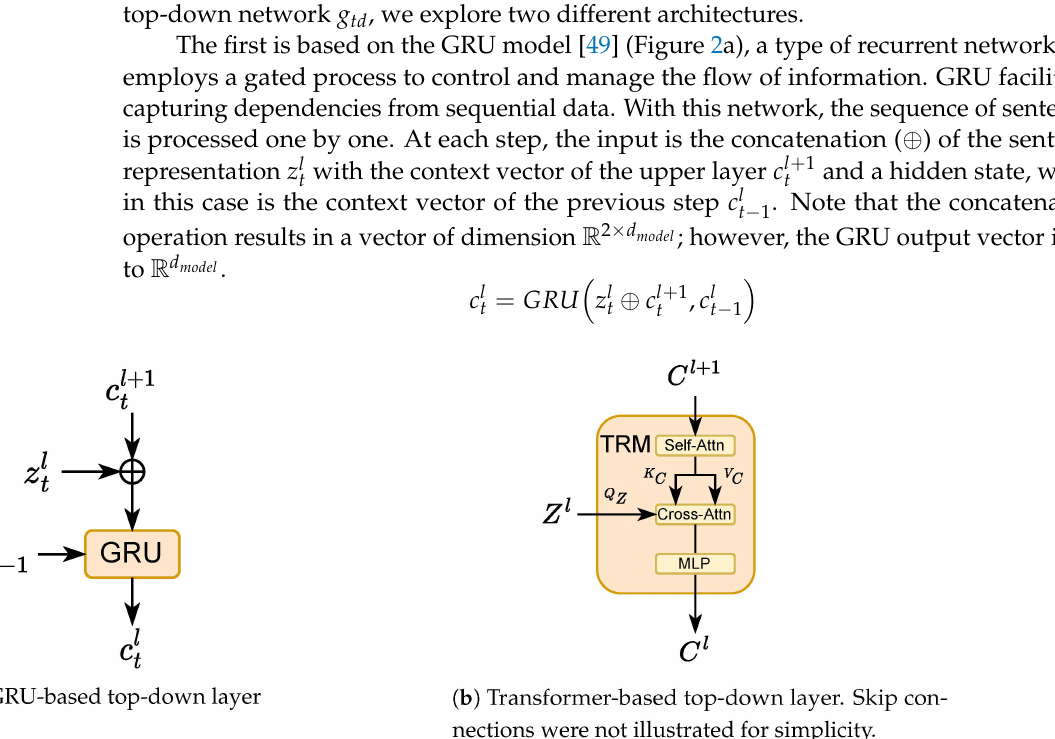
Figure 2. Diagram of the alternative top-down networks: ( a ) based on GRU, processes the sequences step by step, ( b ) based on transformer, processes the sequences as a